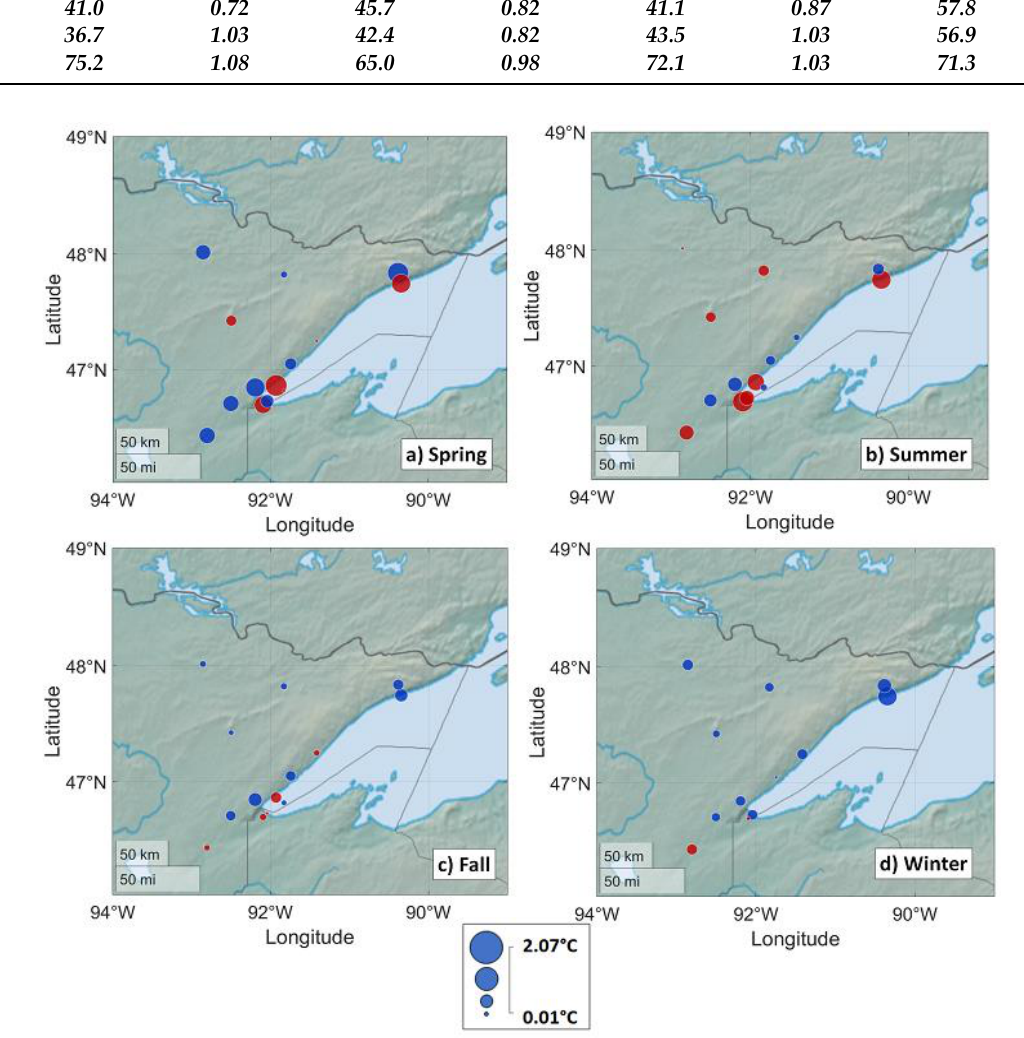
Figure 3. As in Figure 2, except for average temperature change by season: ( a ) spring; ( b ) summer; ( c ) fall; ( d ) winter. Red (blue) bubbles indicate increasing (decreasing) temperature. Table 4. As in Table 3 except for average temperature, dewpoint and relative humidity changes in each season. Values in bold/italics are significant at the 1% level, according to a Wilcoxon signed- rank test.